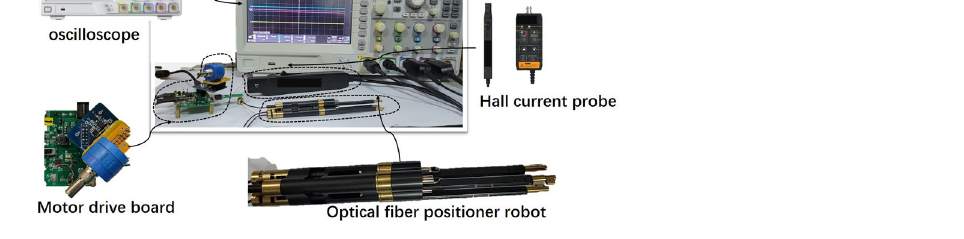
Figure 10. Experiment platform.